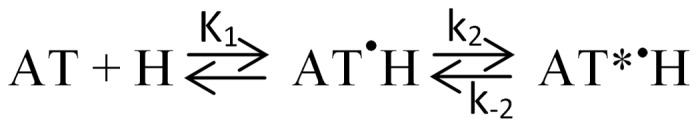
Function of antithrombin variants.Anti-FXa activity of antithrombin proteins secreted to the conditioned medium in presence of heparin. Results are expressed as a percentage of the activity of the S137T variant. Each bar represents the mean ± standard deviation (SD) of two independent experiments performed in duplicate. The differences between mutants were tested by paired t-test (p-value). The “*” indicated differences statistically significant with p<0.05.